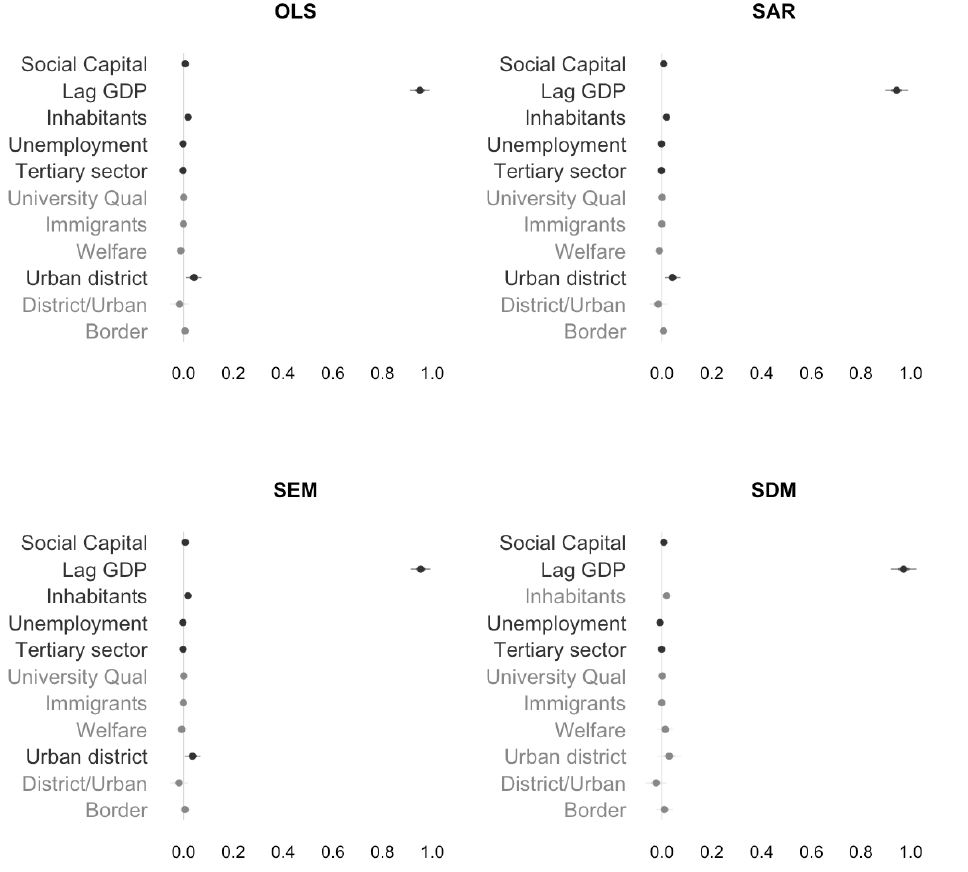
Figure A.1: Spatial regression results, robustness test with lagged GDP t − 5 (dark grey denotes significant estimates